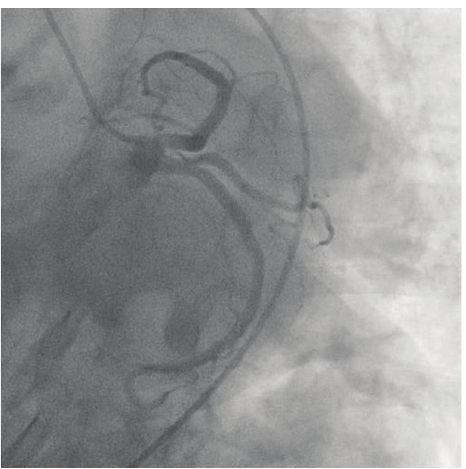
Figure 1: Coronary angiography of the left coronary tree with no angiographic evidence of obstructive disease.